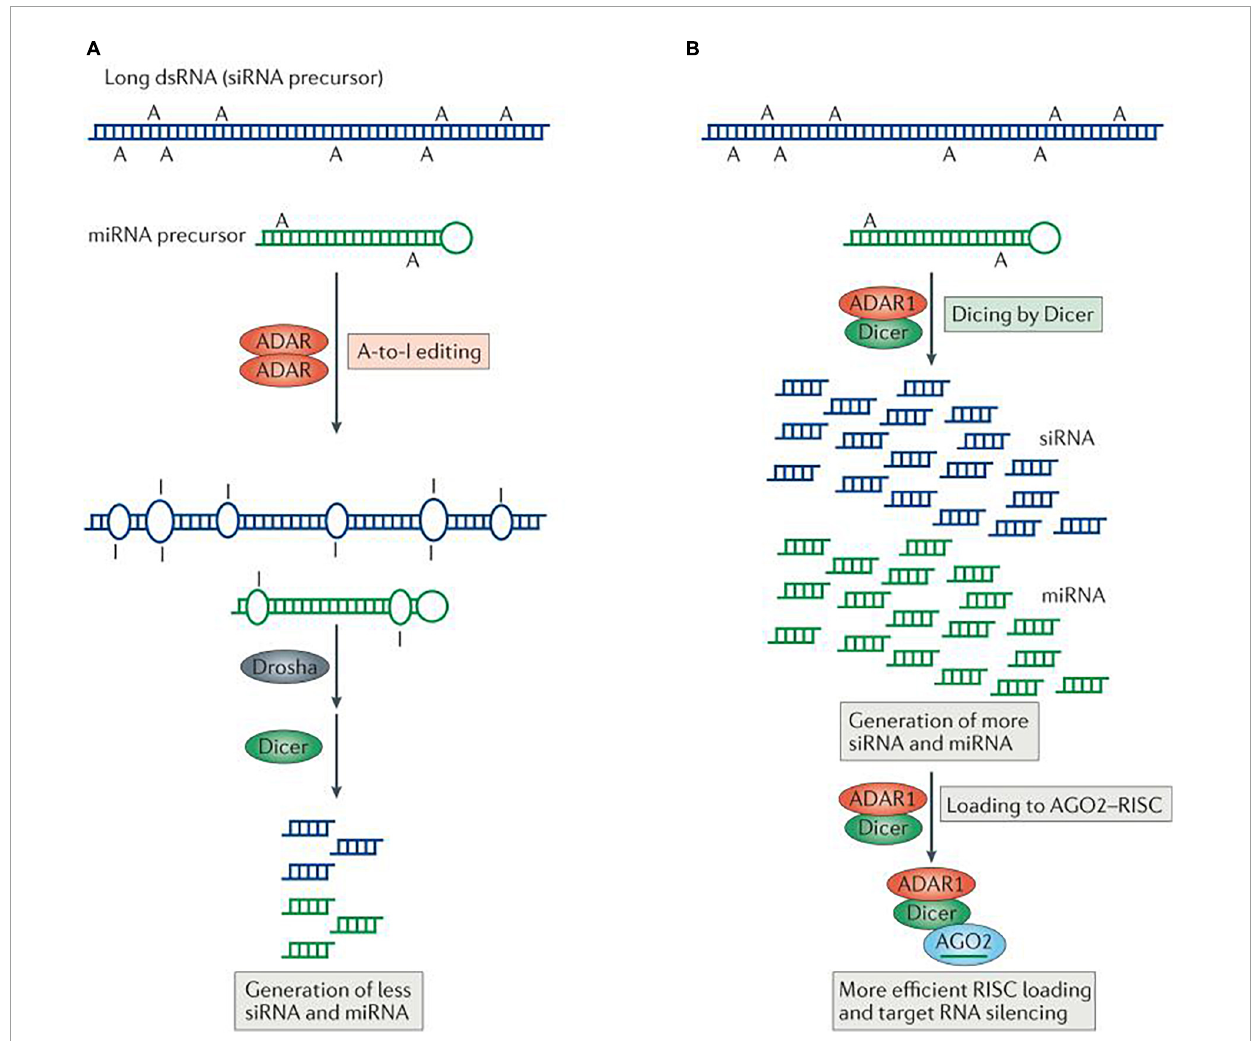
FIGURE12 Regulation of RNA interference (RNAi) by adenosine deaminases acting on RNA (ADARs). Two different types of interaction between RNA-editing and RNAi pathways are known, one antagonistic and the other stimulative. (A) In antagonistic interactions, ADAR–ADAR homodimers edit long double-stranded RNA (dsRNA) and certain microRNA (miRNA) precursors. Editing changes the dsRNA structure and makes it less accessible to Drosha and/or Dicer, consequently decreasing the efficacy of RNAi by reducing the production of short interfering RNAs (siRNAs) and miRNAs. (B) In the case of stimulative interactions, ADAR1, as part of a Dicer–ADAR1 heterodimer, promotes RNAi by increasing the Dicer cleavage reaction rate, thereby generating more siRNAs and miRNAs and enhancing RISC (RNA-induced silencing complex) loading and target mRNA silencing. AGO2, Argonaute 2. Figure from Nishikura (2016), obtained by Springer Nature under license No